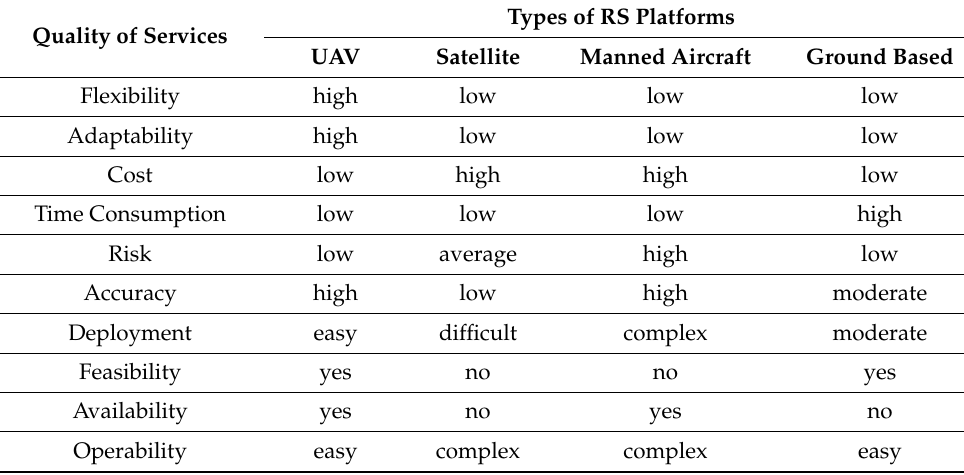
Table 1. QOS comparison of RS platforms used in precision agriculture.